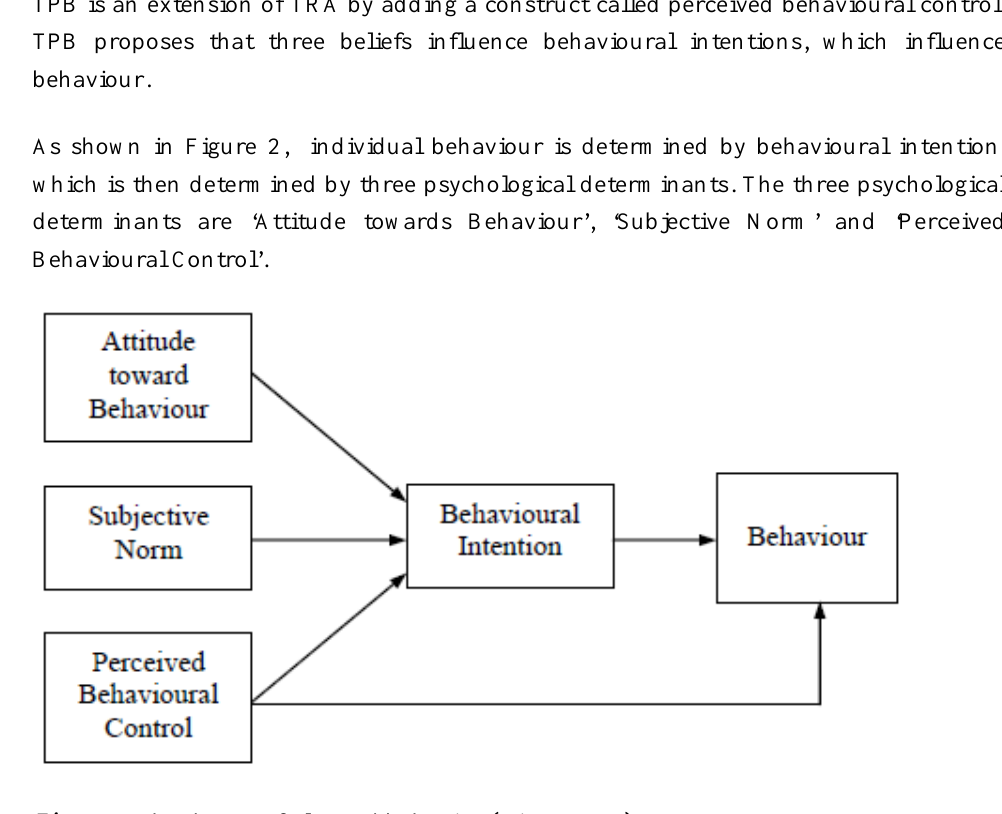
The theory of planned behavior.